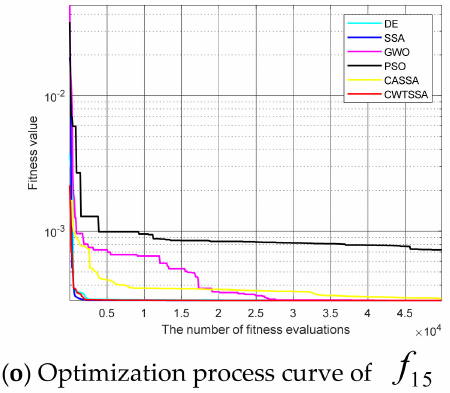
Figure 4. The convergence curves of 15 test functions.